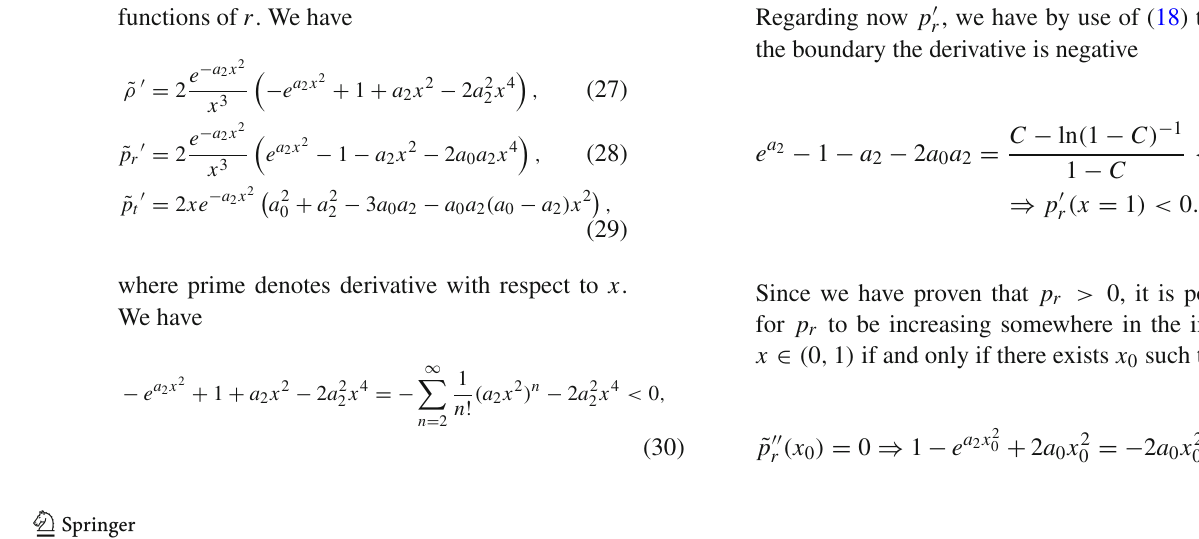
(iv) The density and the pressures should be